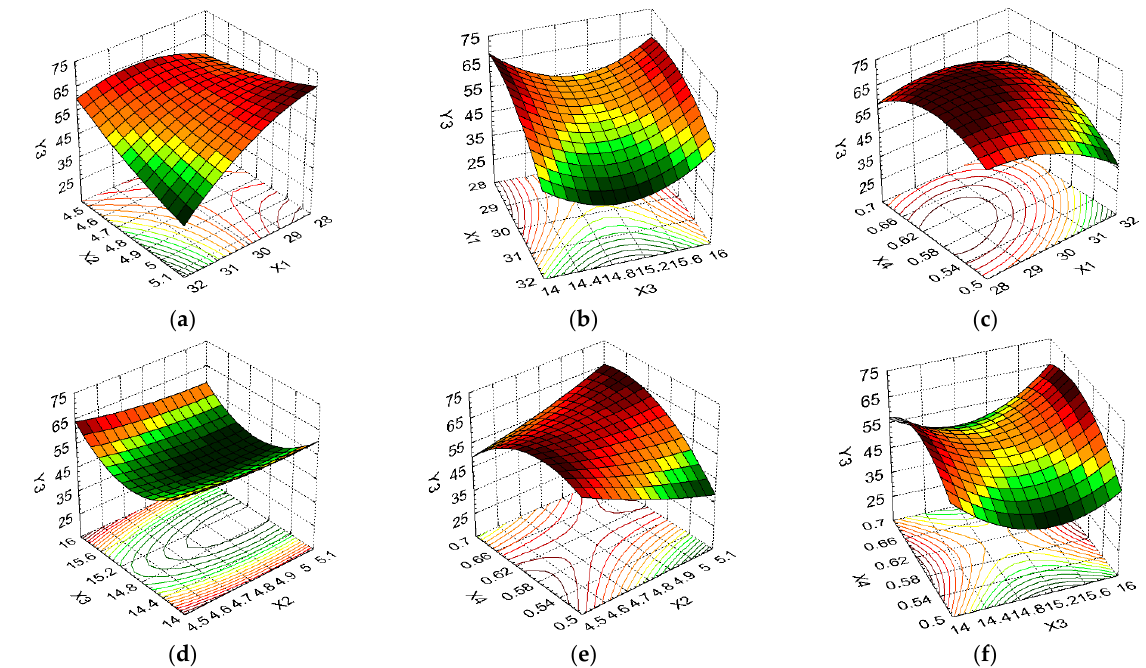
Figure 7. 3D response surface and contour plot showing the effects of different cultivation conditions on the CA (Y 3 ): ( a ) temperature (X 1 ) and pH (X 2 ); ( b ) temperature (X 1 ) and carbon source (X 3 ); ( c ) temperature (X 1 ) and nitrogen source (X 4 ); ( d ) pH (X 2 ) and carbon source (X 3 ); ( e ) pH (X 2 ) and nitrogen source (X 4 ); and ( f ) carbon source (X 3 ) and nitrogen source (X 4 ).